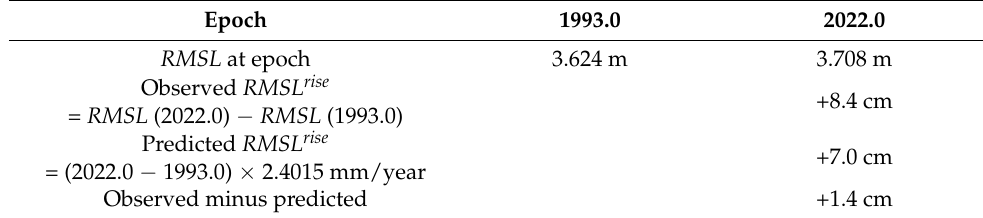
Table 5. Sea level rise at Port Klang vertical datum.